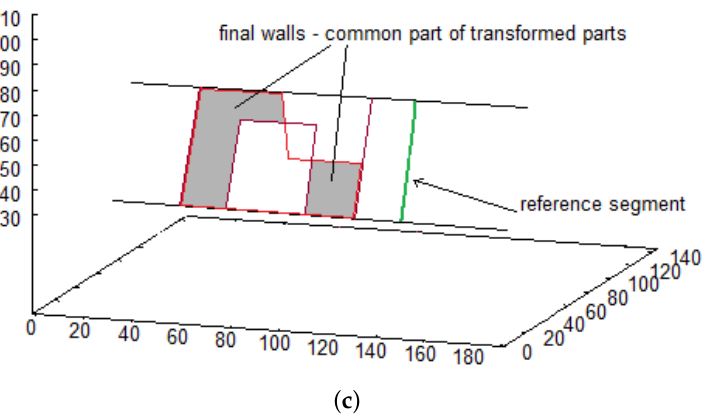
Figure 5. Steps of creating walls. ( a ) cutting from projections; ( b ) projecting onto a plane; ( c ) intersec- tion of intermediate walls.